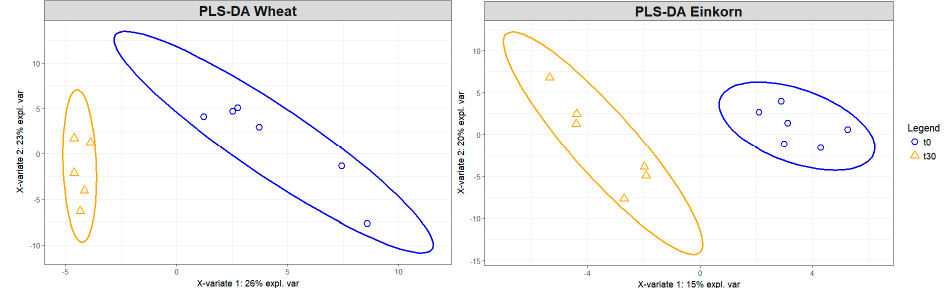
Figure 6. Distribution of fecal volatile molecules, analyzed by gas chromatography-mass spectrometry (GC-MS), before (t0) and after (t30) einkorn (EB) vs. wheat (WB) bread-based dietary intervention.